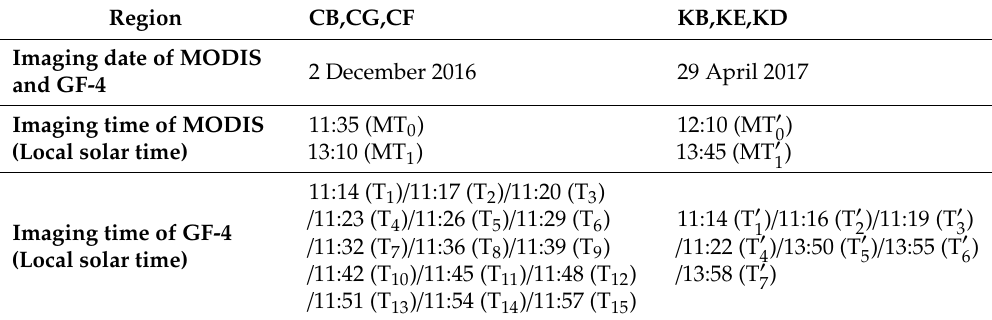
Table 2. Imaging time of MODIS and GF-4 1